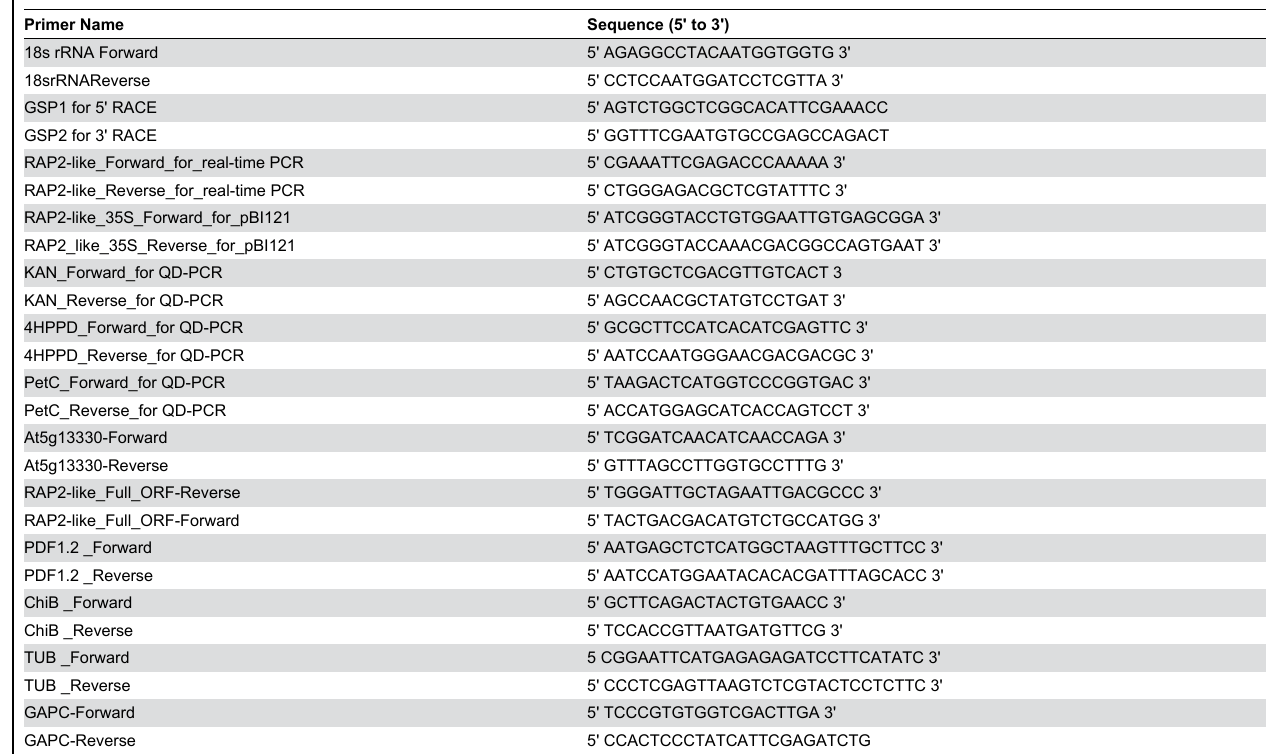
Table 1. Primers used in this